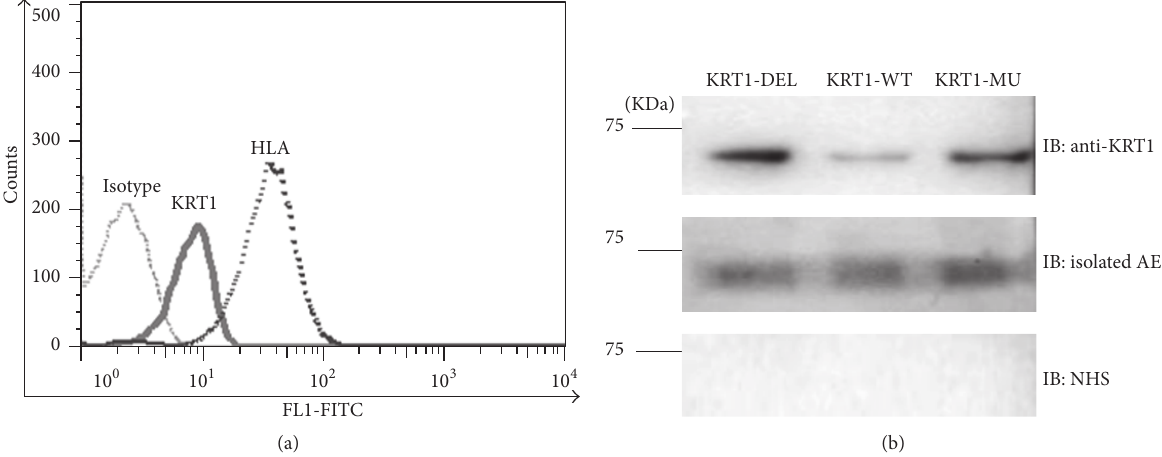
Figure 4: Confirmation of KRT1 as the target of patient antibody. (a) KRT1 was detected on the surface of endothelial cells using a monoclonal antibody; isotype and mAb w6/32 (anti-HLA-class I) were detected as controls. (b) In a western blot, three recombinant KRT1 variants were recognized (IB) by anti-KRT1 polyclonal rabbit serum (top) and by antibodies isolated from serum S5 (middle); normal human serum (NHS) did not react with recombinant KRT1 variants (bottom).